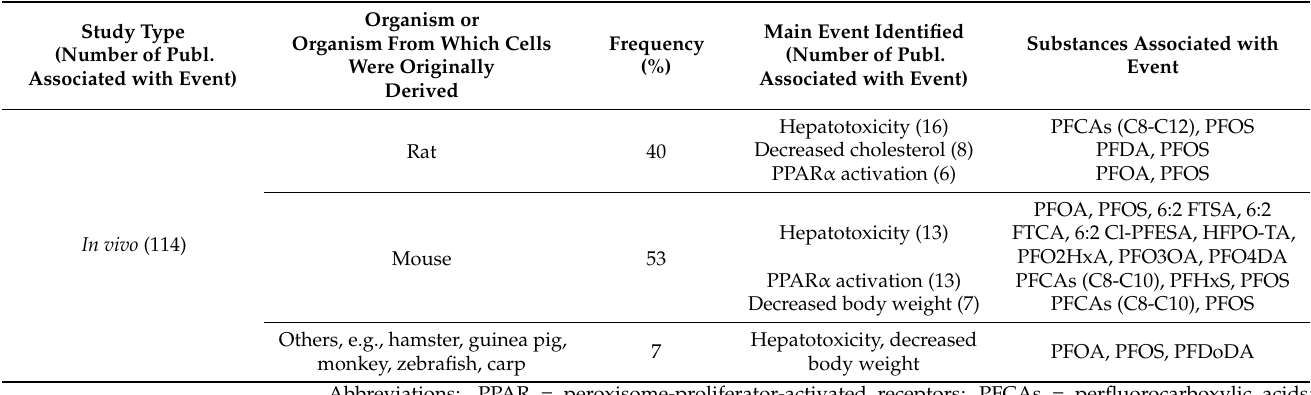
Table 1. In vivo study outcomes related to metabolic